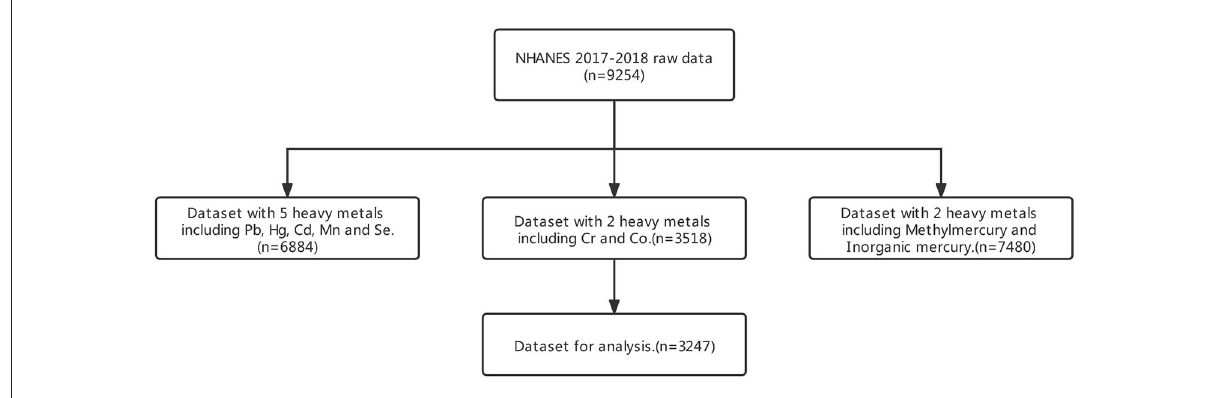
FIGURE1 Flowchart of dataset